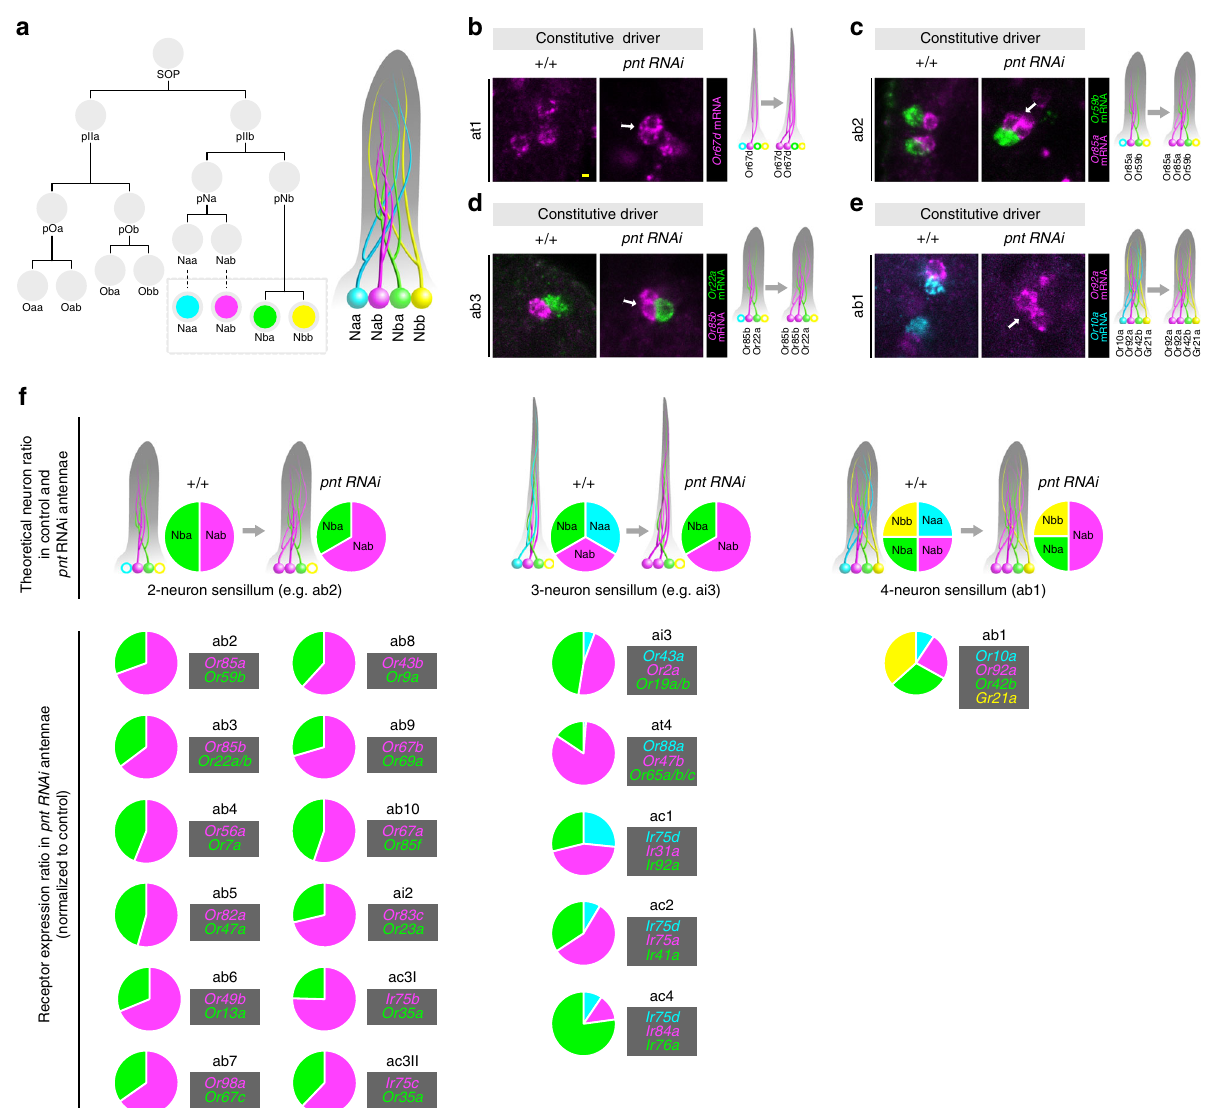
Fig. 9 Loss of Pnt results in Naa-to-Nab transformations in diverse sensillar subtypes. a A sensillum can contain up to four OSNs through differentiation of Naa (cyan), Nab (magenta), Nba (green), Nbb (yellow) terminal daughter cells originating from a single SOP lineage. b Representative images of RNA FISH for Or67d (magenta) in at1 sensilla in control and pnt RNAi antennae. In pnt RNAi antennae, Or67d-expressing OSNs are duplicated (arrow). A schematic of the proposed Naa-to-Nab fate transformation is shown on the right (color scheme as in ( a )). Scale bar = 2 µ m. The open circles in this and other schematics represent OSN precursors that have undergone apoptosis. c Representative images of RNA FISH for Or85a (magenta) and Or59b (green) in ab2 sensilla in control and pnt RNAi antennae. In pnt RNAi antennae, Or85a OSNs (Nab) are duplicated (arrow), while Or59b OSNs (Nba) are unaffected. d Representative images of RNA FISH for Or85b (magenta) and Or22a (green) in ab3 sensilla in control and pnt RNAi antennae. In pnt RNAi antennae, Or85b OSNs (Nab) are duplicated (arrow), while Or22a OSNs (Nba) are unaffected. e Representative images of RNA FISH for Or92a (magenta) and Or10a (cyan) in ab1 sensilla in control and pnt RNAi antennae. In pnt RNAi antennae, Or92a OSNs (Nab) are duplicated (arrow), while Or10a OSNs (Naa) are lost. f Top: theoretical ratios of OSN types in 2-, 3- and 4-neuron sensilla in control and pnt RNAi antennae, assuming Naa-to-Nab fate transformation (i.e. loss of Naa OSNs, and duplication of Nab OSNs). Bottom: experimentally determined OSN ratios in all sensilla in pnt RNAi antennae using as a proxy the normalized ratios of olfactory receptor mRNA expression from antennal transcriptomes (see Supplementary Fig. 6e). In ab10, Or49a is reported to be coexpressed with Or85f 13 , but transcript levels for this gene were below the cut-off applied during the analysis of these RNA-seq datasets